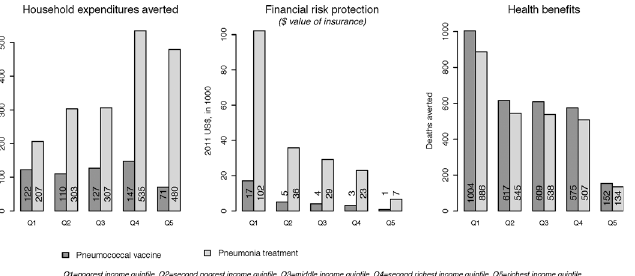
Fig 2. Level and distribution of household expenditures averted, health benefits (deaths averted and severe episodes of pneumococcal pneumoniae averted), and financial risk protection, for scale-up of pneumococcal vaccination and pneumonia treatment provided by universal public finance in